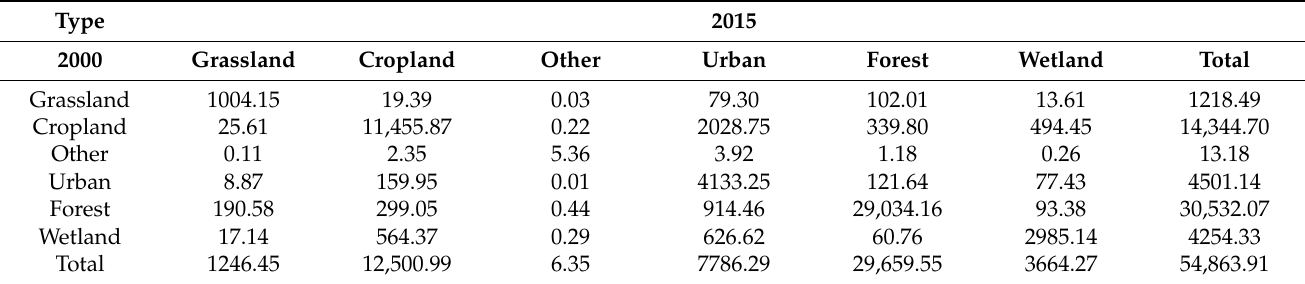
Table 4. Ecosystem transition matrix between 2000 and 2015 in the Greater Bay Area (Unit: Area km 2 ).